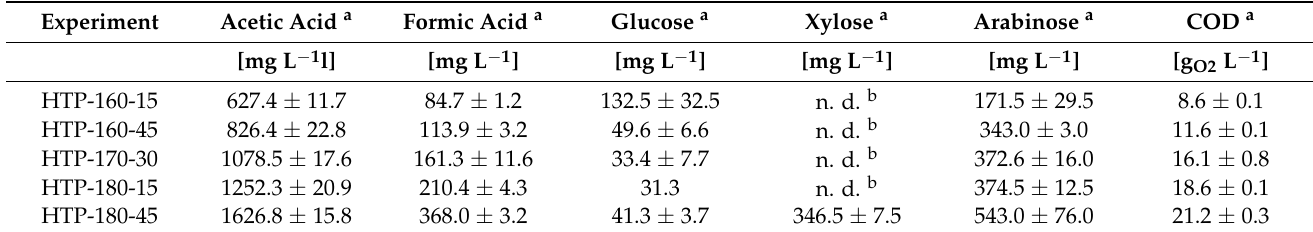
Table 2. Content of soluble organic fractions in process water under different hydrothermal pretreat- ment conditions considering acids, sugars and